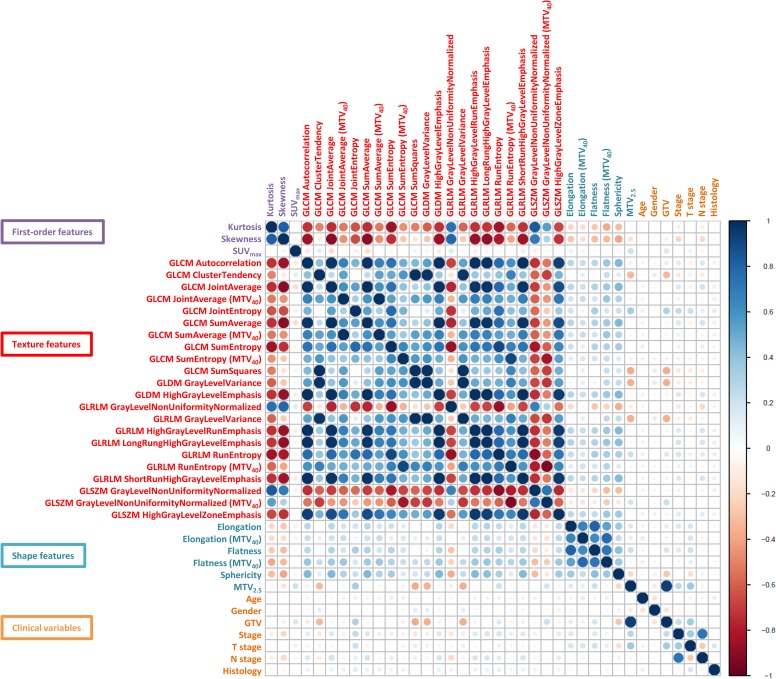
Correlation coefficients of the robust independent PET radiomics features and clinical variables.Positive correlation coefficients are displayed in blue and negative correlation coefficients in red color. Color intensity and the size of the circle are proportional to the correlation coefficients. A distinction was made between features calculated from MTV2.5 and MTV40.